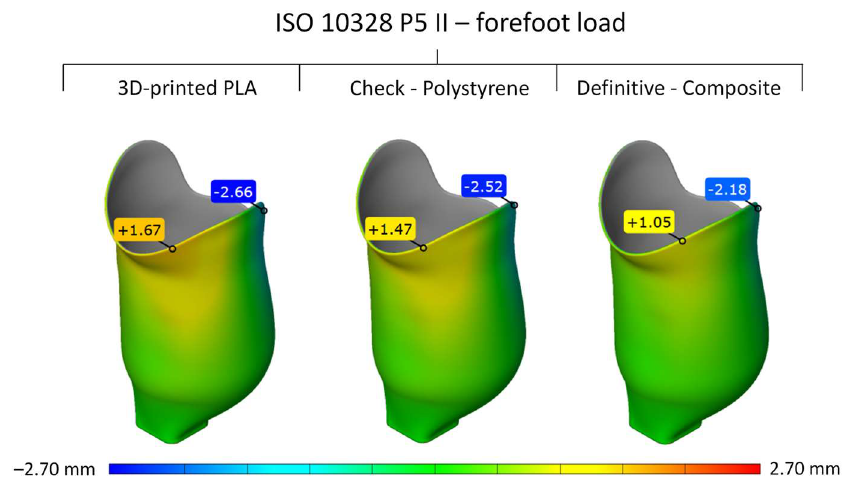
Figure 11. Global deformation of PLA, composite, and polystyrene sockets for load case P5 II at settling test